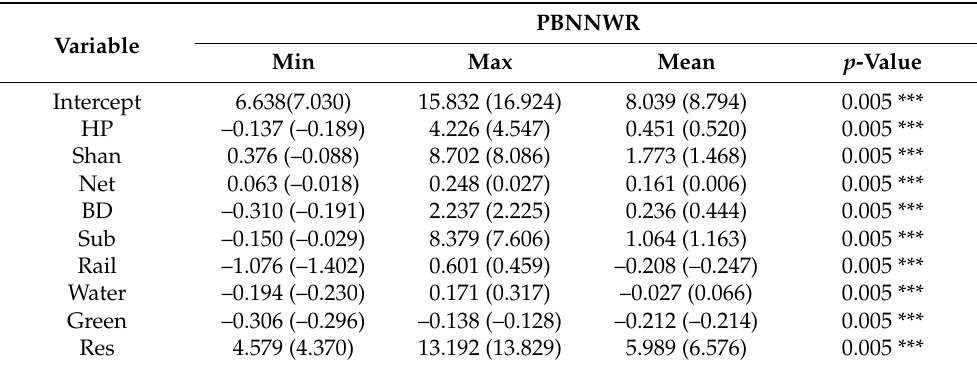
Figure 10. The trend of R 2 and RMSE: ( a , b ) on weekdays; ( c , d ) on weekends. Applying the optimal model to the complete samples, the distribution of regression coefficients for the associated factors of vitality was obtained. We constructed a statistic to test the spatial non-stationarity of the regression coefficients [63], and the statistical results show that the nine associated factors significantly influenced urban vitality (Table 4). Res, Sub, Shan, HP, Net, and BD all had a positive relationship with urban vitality, whereas Rail and Green had a depressing effect on urban vitality. For Water, there was an opposite effect on weekdays and weekends, with average contributions of –0.027 and 0.066%, respectively. Table 4. Regression coefficients between influence indicators and urban vitality.